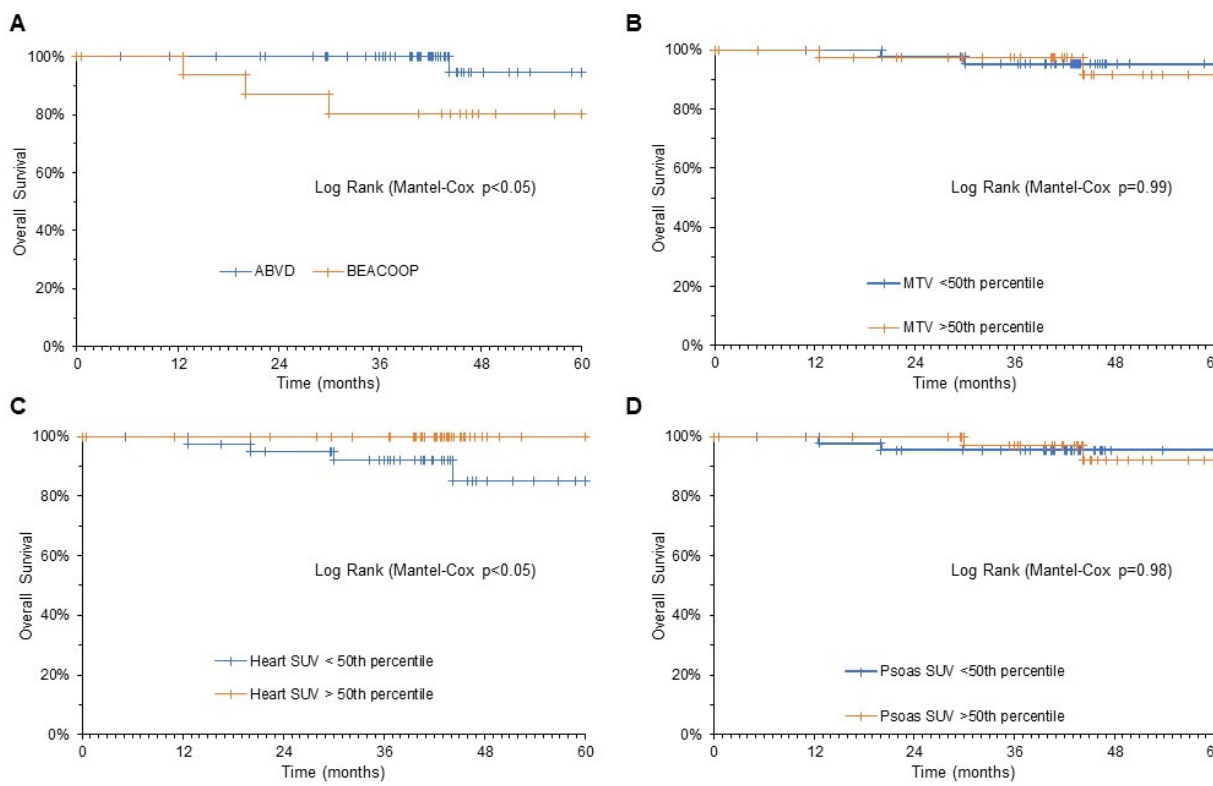
Figure 3. Kaplan–Meier analysis of OS. Mortality rate was predicted by the need of therapy escalation according to DSS ( A ) and cardiac SUV at interim PET ( C ). By contrast, disease bulk evaluated by MTV ( B ) and skeletal muscle SUV ( D ) were devoid of this predictive power.